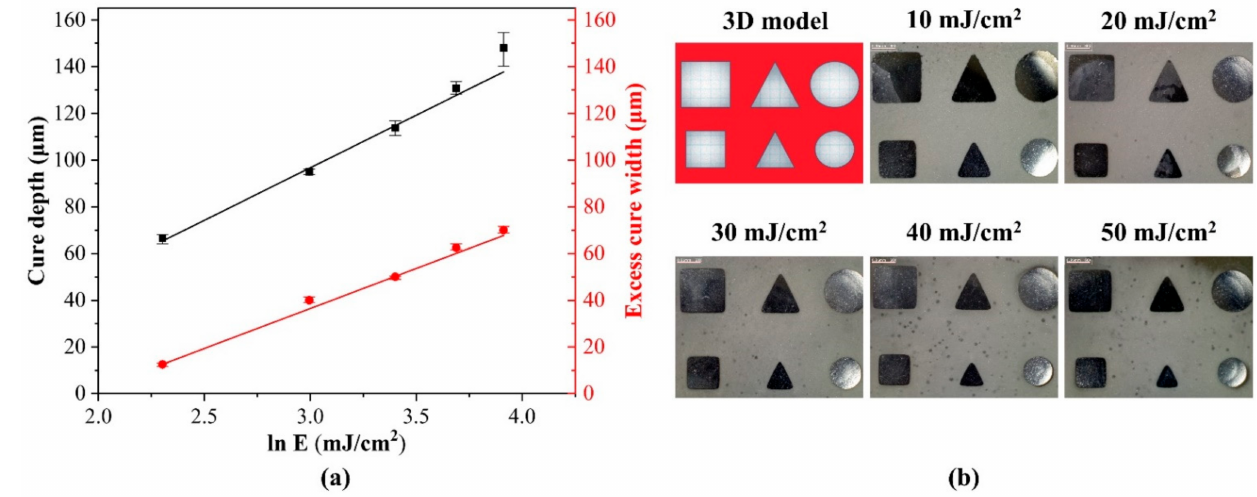
Figure 5. ( a ) Effects of exposure dose on the cure depth and excess cure width of the planetary milled mica slurry (53 vol.%). ( b ) Optical images of cured monolayers depending on the exposure dose.